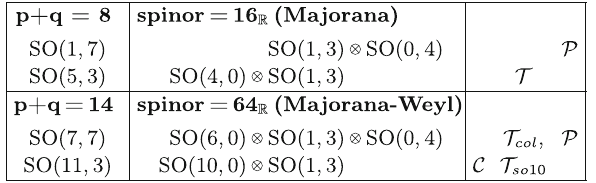
Table1 Breakingofunifyingorthogonalgroupsandemergingdiscrete